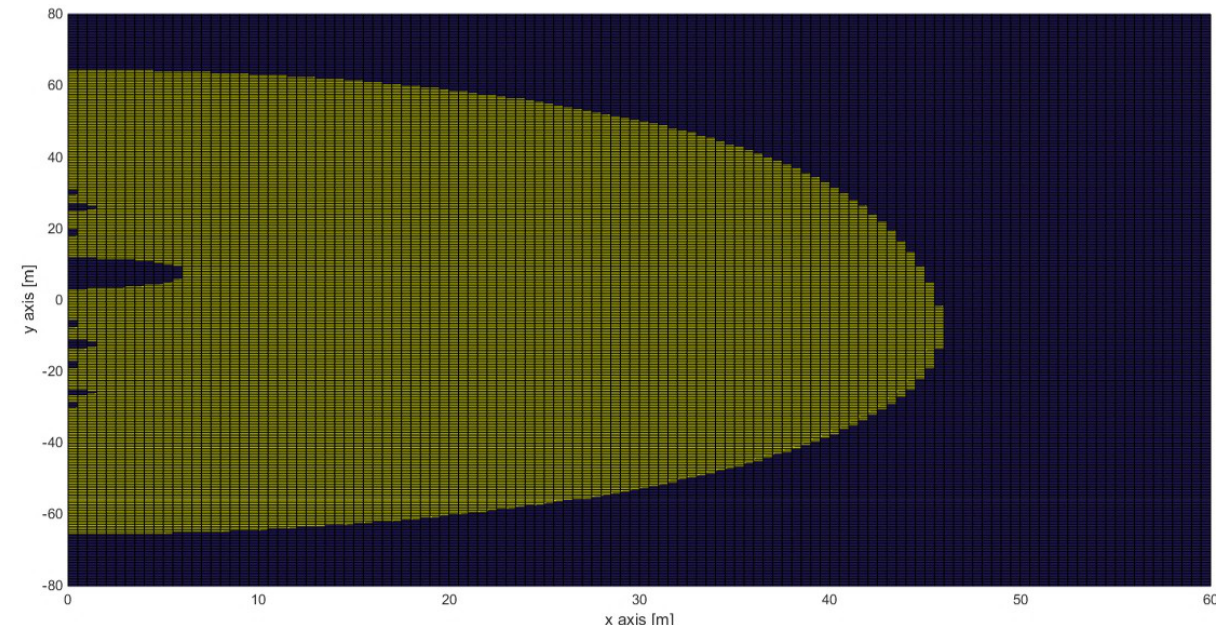
Figure 29. Area of electric field strength, with values higher (yellow) and lower (blue), than the limit of 1.25 V/m, for method “C”, of linear current source, for an electrode station of 6 linear frames in a row, with d frames = 6.50 m, each frame consisting of 13 electrodes of active length L = 2.13 m, D el = 0.50 m, ρ w = 0.25 Ω · m, θ = 248 ◦ (area of Korakia), J full_load_steady = 22 A/m 2 (steady state